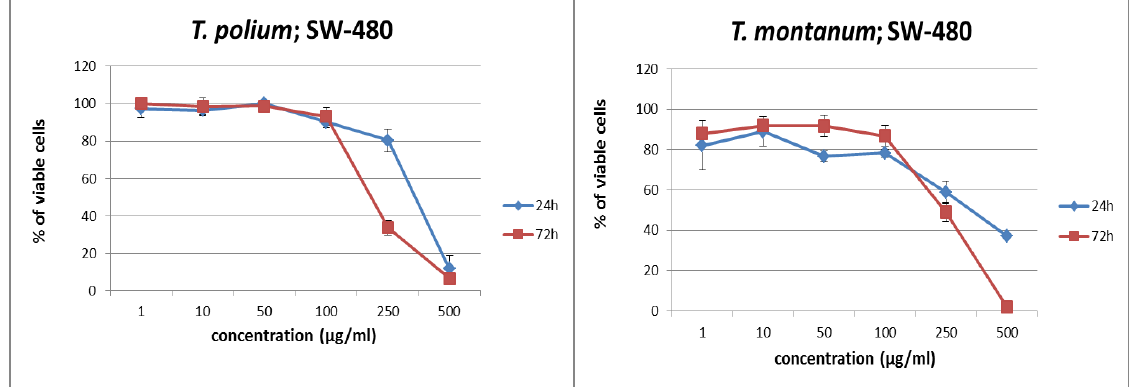
Figure 2. Cytotoxic activity of the methanol extracts from T. polium and T. montanum on SW-480 cell line. Results are expressed as means ± SE for three independent